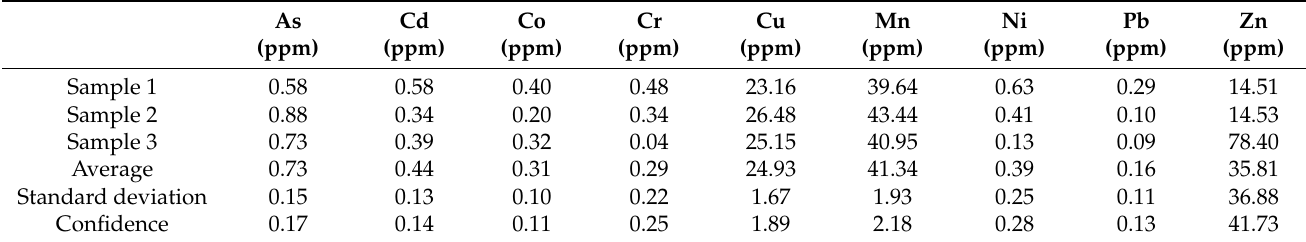
Table 9. Minor elements results for dry samples.